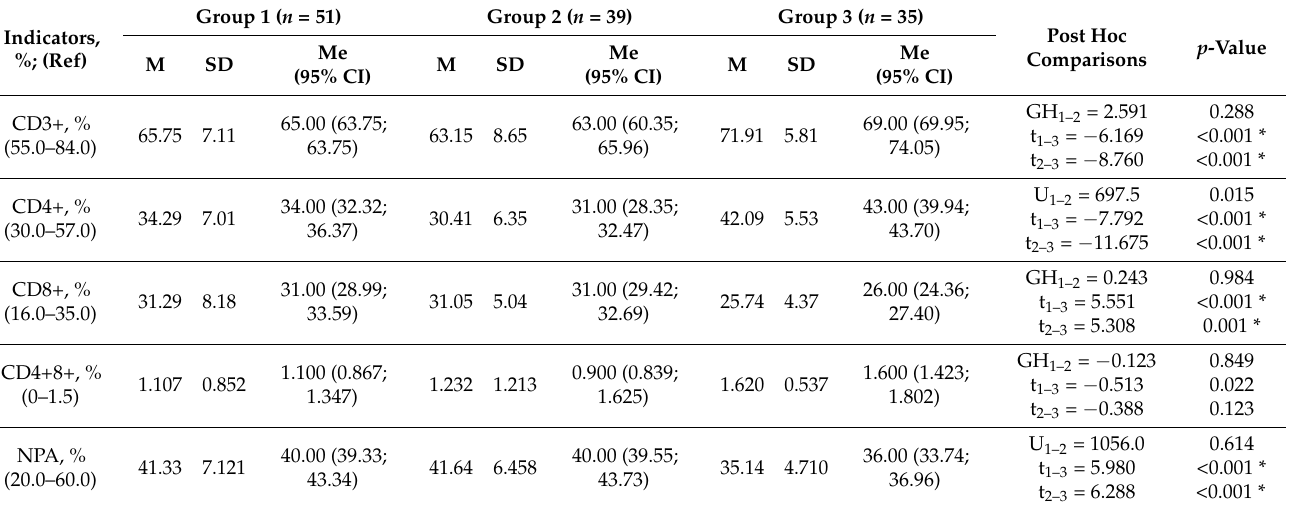
Table 1. Comparative analysis of indicators of T-cellular immunity of three groups of workers in chrysotile asbestos